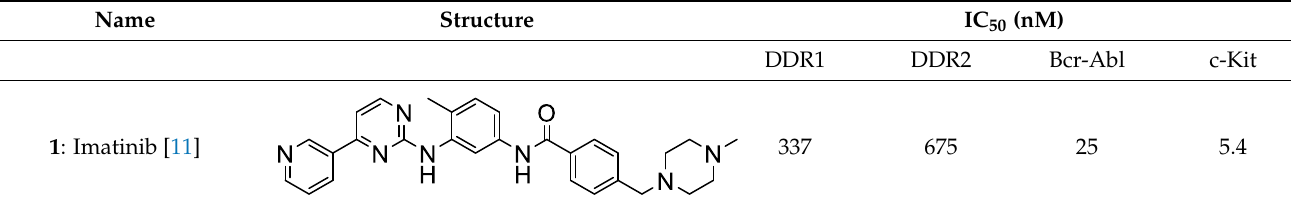
Table 1. DDR inhibition profiles of some approved DDR-binding drugs.